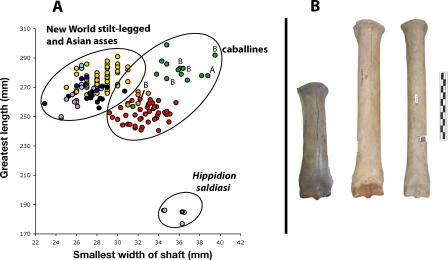
Metatarsal Shape and Size in Pleistocene and Extant Equids(A) Bivariate plot showing metatarsal shape and size in extant and extinct horses. Modern asses: kiang (E. kiang) = light blue circles; onager (E. hemionus onager) = dark blue; kulan (E. hemionus kulan) = purple. Pleistocene equids: stilt-legged from Alaska and the Yukon = black; E. lambei (Alaska) = red; stilt-legged from Natural Trap Cave (Wyoming) = yellow; caballines from Natural Trap Cave = orange; caballines from Alberta = green; H. saldiasi from southern Patagonia = grey. “A” and “B” above/beside points of caballine horses denote the phylogenetic clade to which the specimens belong (Figure 5). Not all of the specimens were genetically analyzed.(B) Metatarsal shape in Pleistocene horses. From left to right: H. saldiasi (southern Patagonia); E. lambei (Yukon); NWSL (Yukon). Scale bar is 10 cm.